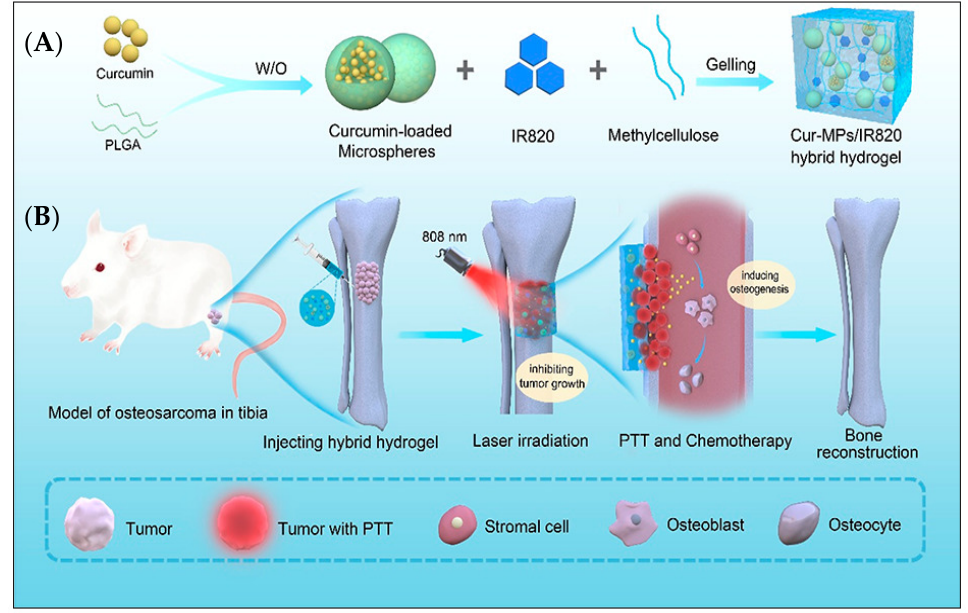
Figure 4. ( A ) Preparation scheme for the Cur ‐ MP/IR820 hybrid hydrogel. ( B ) Illustration of Cur ‐ MP/IR820 hybrid hydrogel applied in osteosarcoma chemo ‐ photothermal combined therapy and following bone reconstruction. Reproduced with permission from Bowen Tan et al., 2021 [215].